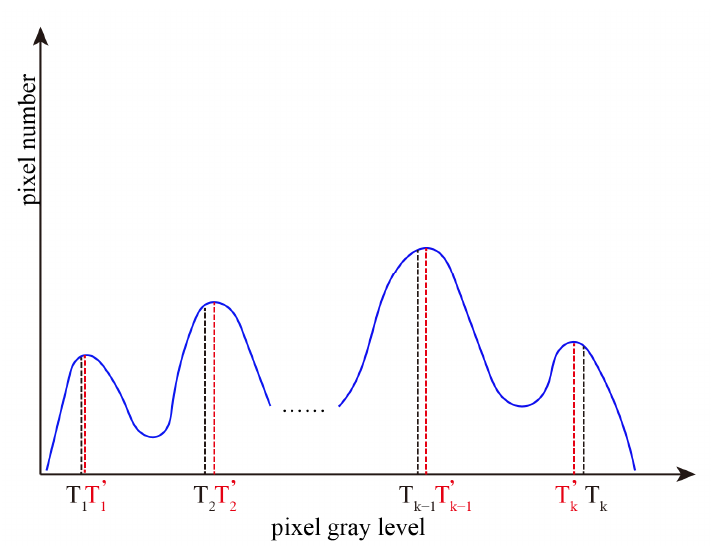
Figure 4. The optimal thresholds obtained by interval iterative Otsu algorithm based on region growing.